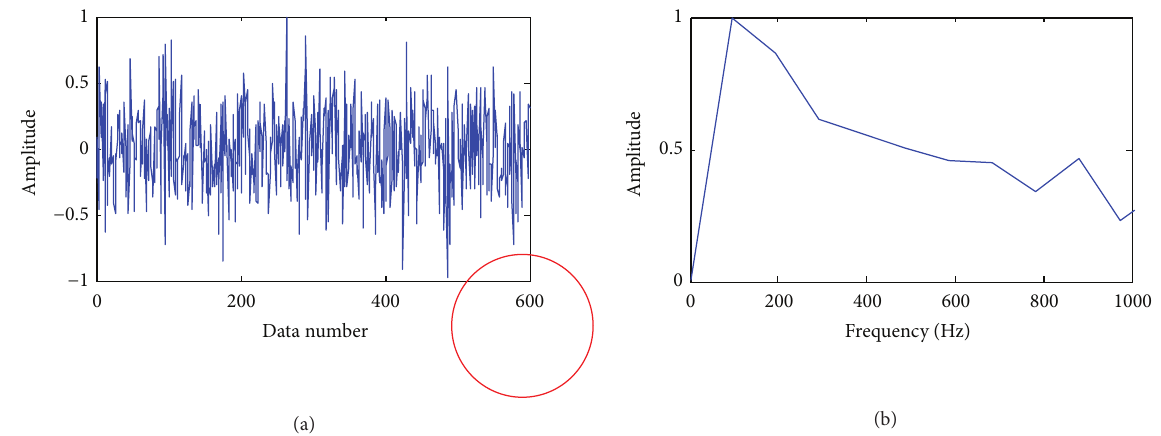
Figure 9: (a) Random sampling and (b) envelope spectrum of the original signals with 600